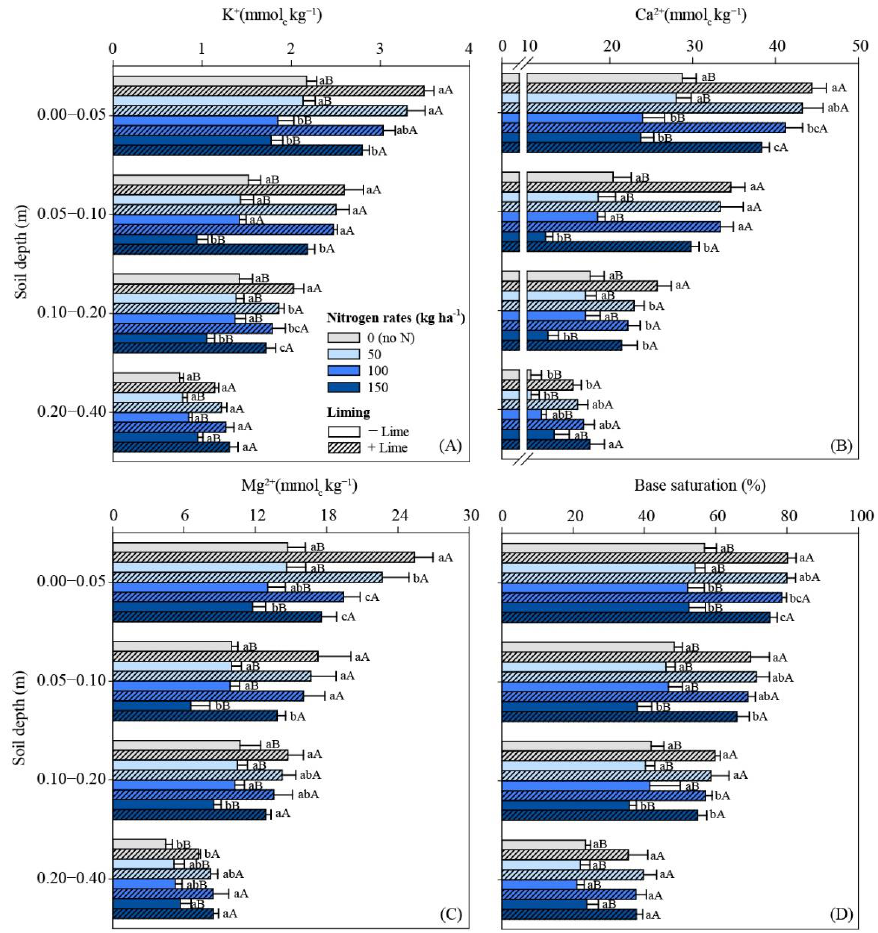
Figure 6. Changes in soil exchangeable K + ( A ), Ca 2+ ( B ), Mg 2+ ( C ), and base saturation ( D ) under different treatments (0 (no N applied), 50, 100, and 150 kg N · ha –1 × absence ( − Lime) and presence (+Lime) of lime application). Different lowercase and uppercase letters indicate significant differences between N rates and lime applications, respectively, by Student ’ s t -test at p ≤ 0.05. The error bars express the standard error of the mean ( n = 4).